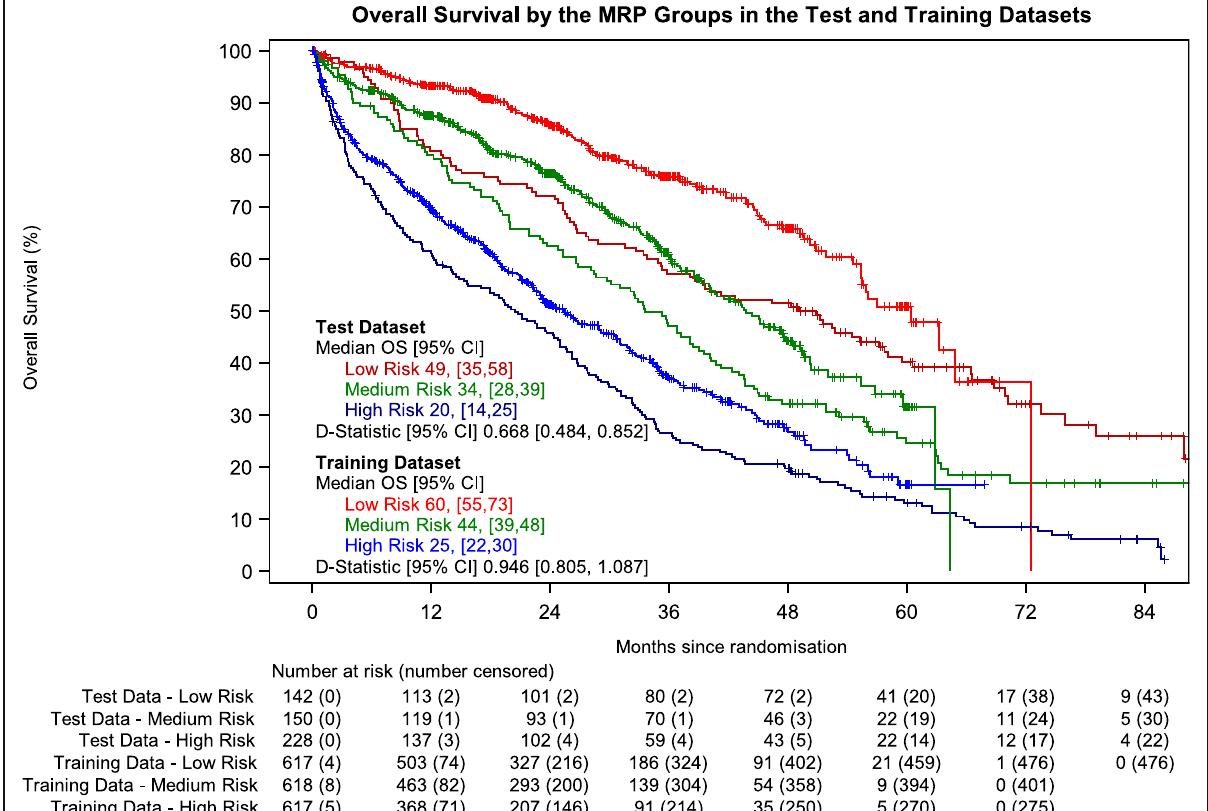
Fig. 3 Kaplan-Meier curves for overall survival by the derived risk groups in the test and training datasets